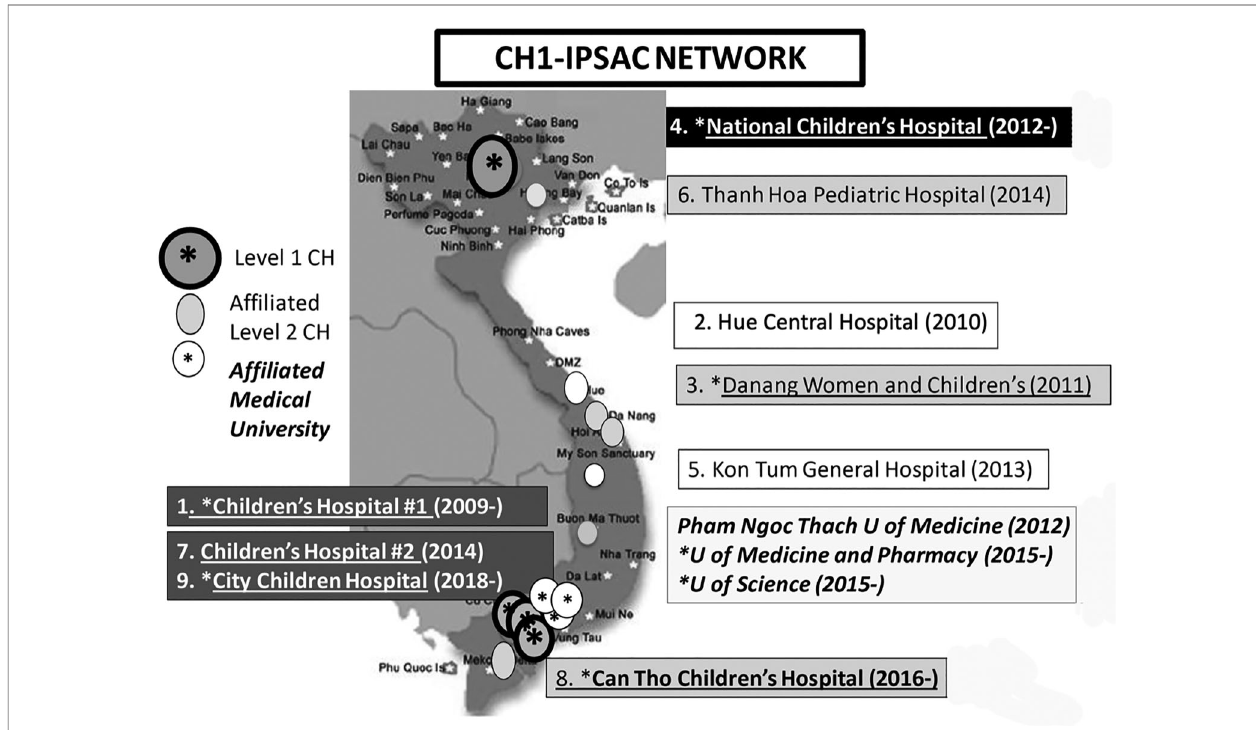
FIGURE 1 | Map of Vietnam and sites of IPSAC-VN activities in Vietnam. Level 1 Children ’ s Hospital CH (in shading circle and asterisk in the map); the National Children ’ s Hospital 1 NCH in the capital city of Hanoi, and Children ’ s Hospital 1 (CH1), Children ’ s Hospital 2 (CH2), City Children ’ s Hospital. (CCH) in Ho Chi Minh City. Level 2 CH (in shading ellipse in the map); with Danang Women and Children ’ s Hospital DWCH, Thanh Hoa Pediatric Hospital and Can Tho Children ’ s Hospital (CTCH). The adult hospitals (in white circle in the map); with Hue Central Hospital and Kon Tum General Hospital. The teaching universities (in white circle and asterisk in the map); Pham Ngoc Thach University of Medicine, University of Medicine and Pharmacy; University of Science. The initiating years of the activities are depicted, with ongoing efforts at 1. CH1, 3. DWCH, 4. NCH, 8. CTCH, 9.